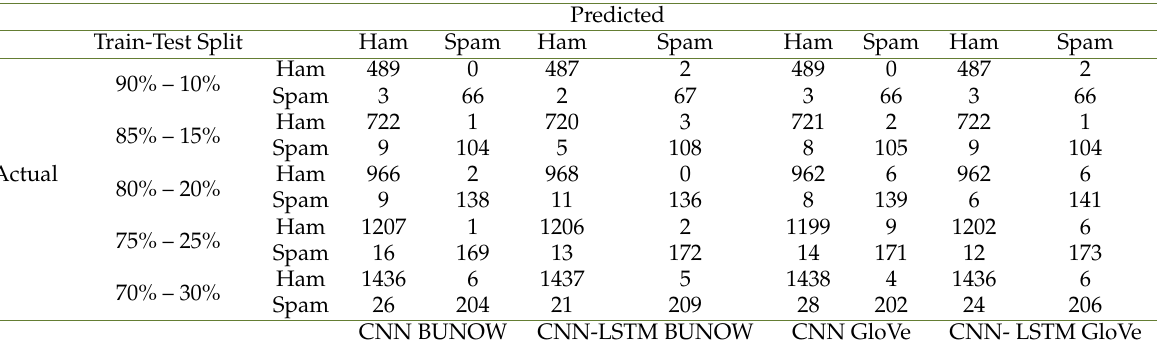
Table 1. Confusion Matrices for all models.